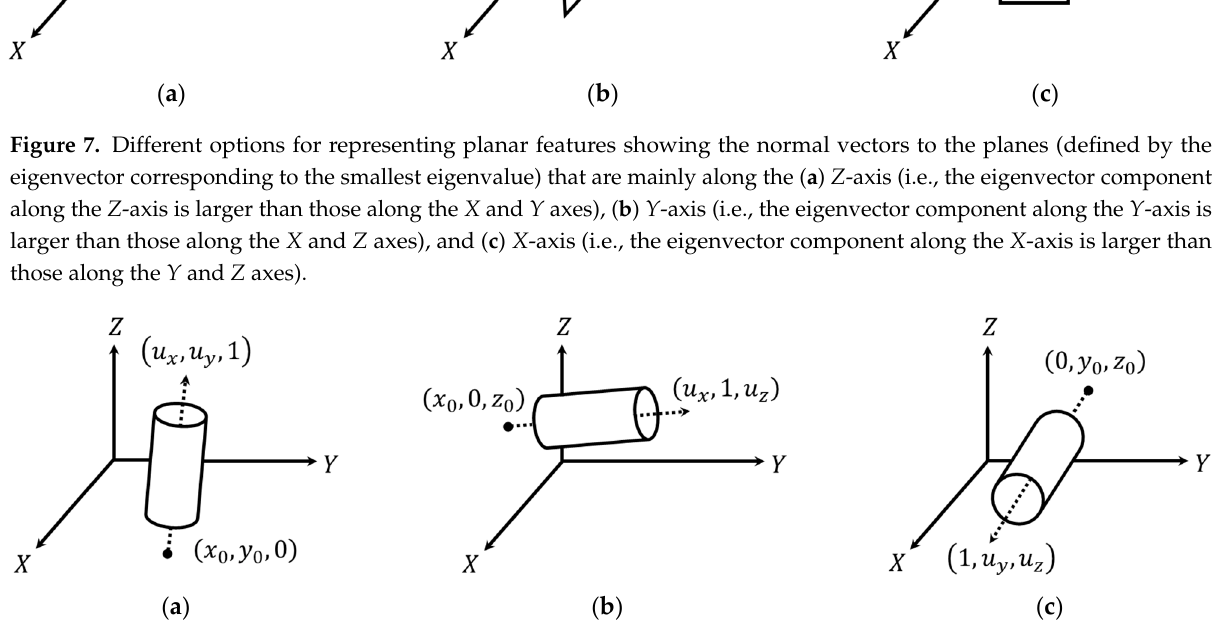
Figure 8. Different options for representing cylindrical features with directions (defined by the eigenvector corresponding to the largest eigenvalue) that are mainly along the ( a ) Z -axis (i.e., the eigenvector component along the Z -axis is larger than those along the X and Y axes), ( b ) Y -axis (i.e., the eigenvector component along the Y -axis is larger than those along the X and Z axes), and ( c ) X -axis (i.e., the eigenvector component along the X -axis is larger than those along the Y and Z axes).